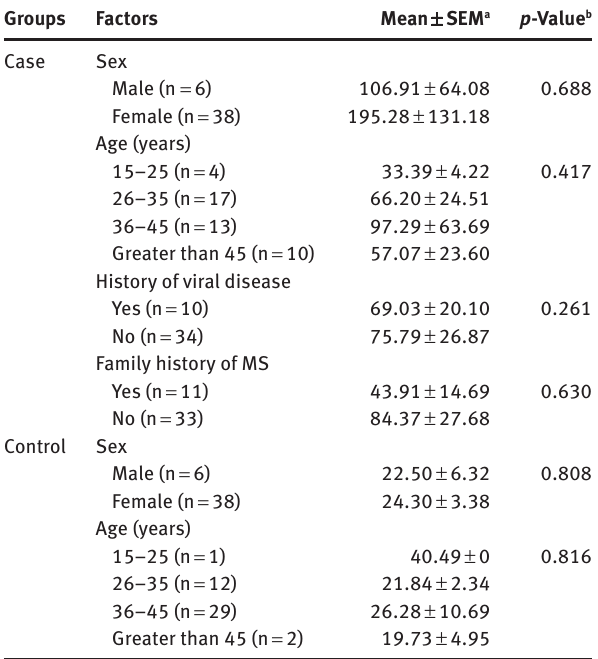
Table 1: Comparison of mean IL-33 plasma levels in different factors within each group.